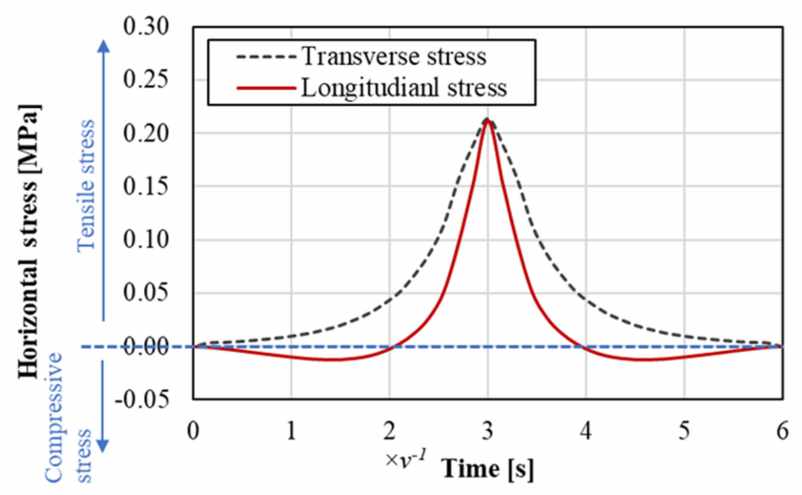
Figure 2. Stress reversal at the bottom of the asphalt